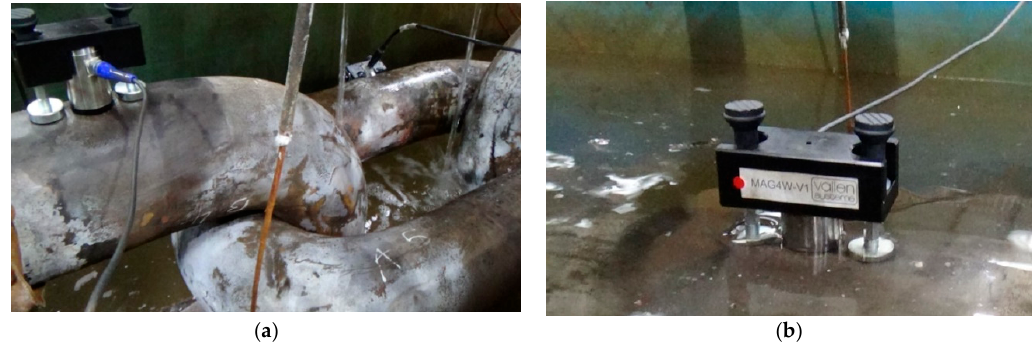
Figure 6. AE reproducibility was verified as the tank was being filled with water ( a ) before the onset of the experiment ( b ).